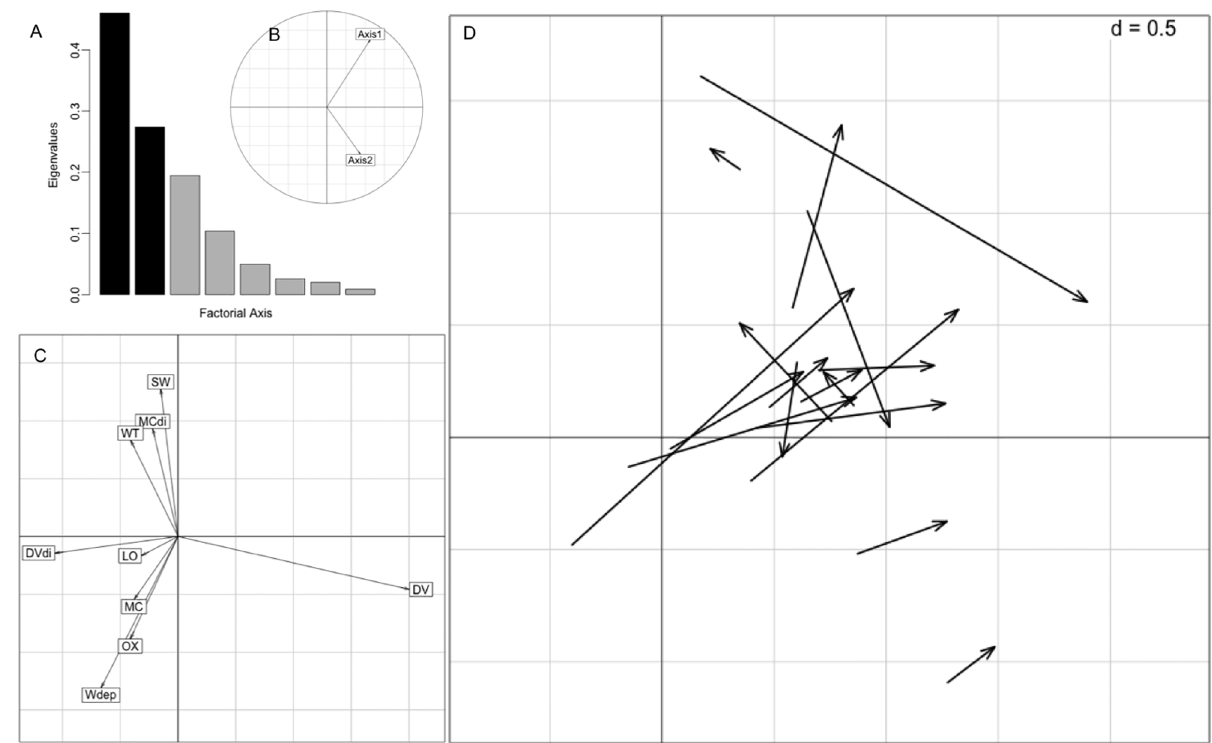
Fig 3. Patch level resource selection plots from the K-select analysis for radio-tracked alligators at Ross Barnett Reservoir and the Pearl River, Mississippi, USA, 2012 – 2013. (A) Scree plot of eigenvalues where Axis 1 and 2 are shown as black bars and other axes are represented as gray bars. (B) Orthogonality plot for Axis 1 and 2. (C) Habitat variable loadings. Abbreviations of habitat variables: main channel (MC), backwaters and oxbow lakes (OX), floating, emergent vegetation (DV), lotus (LO), forest and swamps (SW), very shallow wetlands (WT), water depth (Wdep), distance to main channel (MCdi), and distance to floating, emergent vegetation (DVdi). (D) Marginality vectors of each animal that point from the centroid of available resource space to the centroid of used resource space.